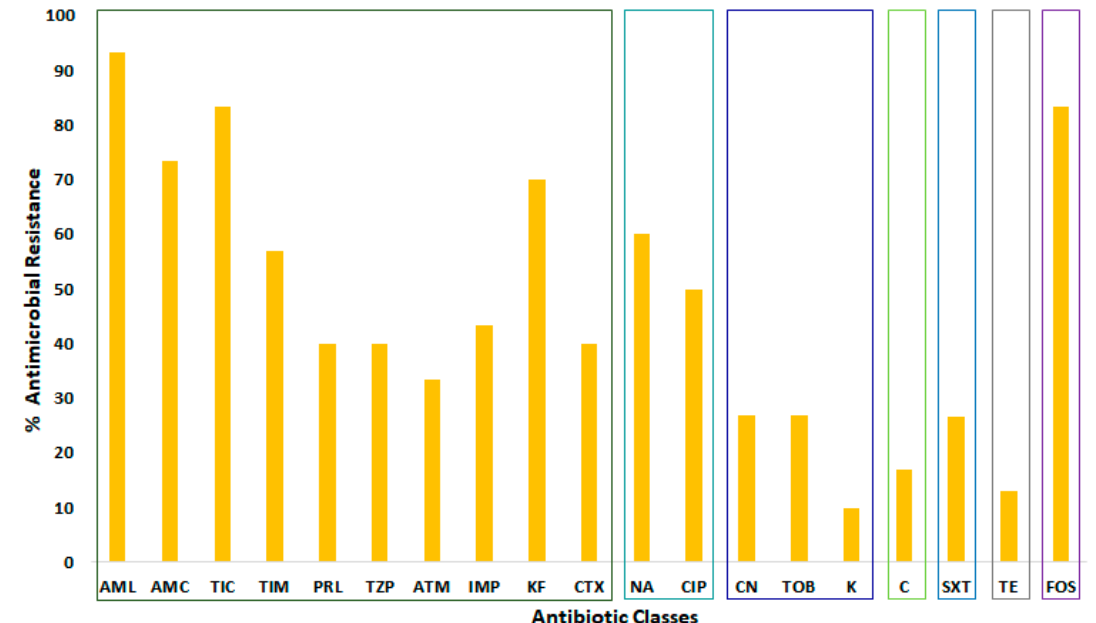
Figure 2. Susceptibility and resistance profiles (%) of Aeromonas spp. ( n = 30) isolates to 19 antibiotics. Antibiotic abbrevi-